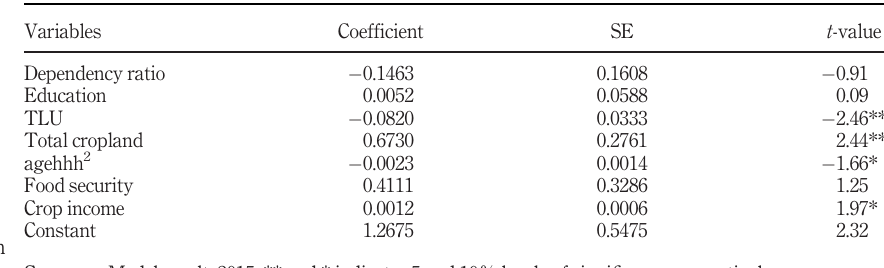
Table VII. Determinants of households ’